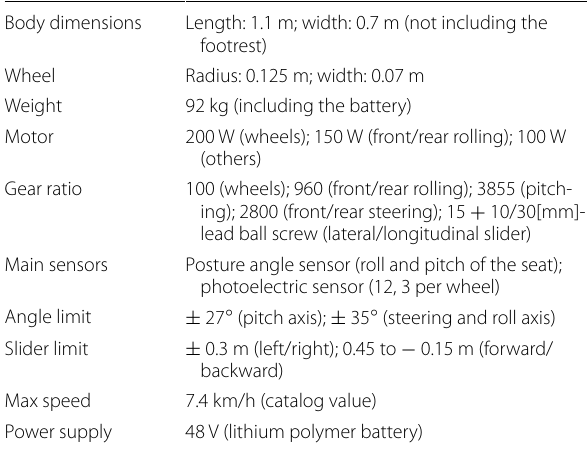
Table 1 Main specifications of the P-WA MK-II